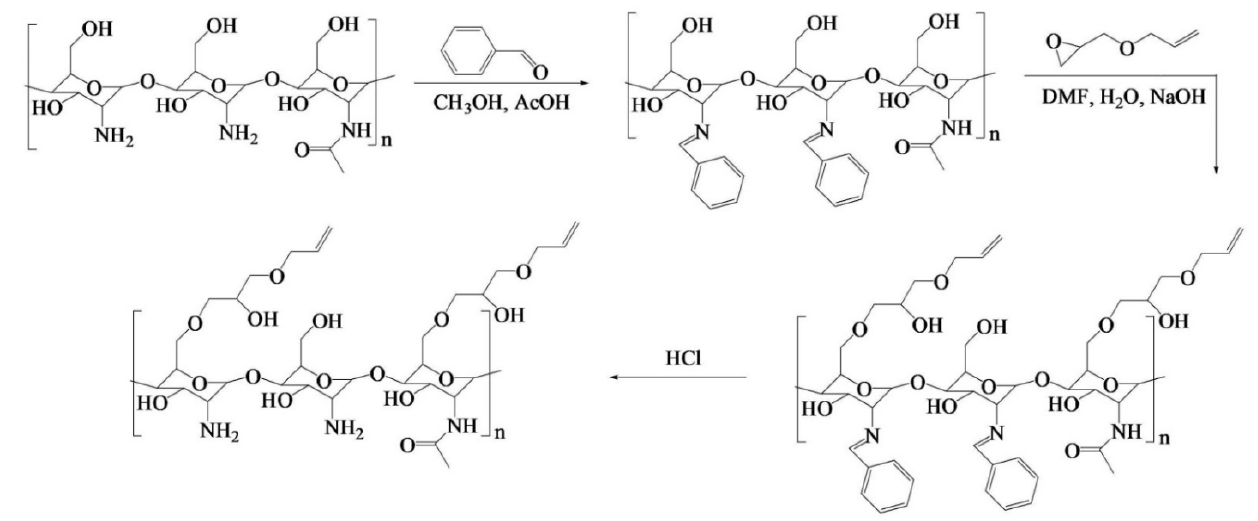
Figure 19. Synthesis route of OAL-CS as designed by Ding et al. Adapted with permission from [88]; published by Elsevier, 2020.